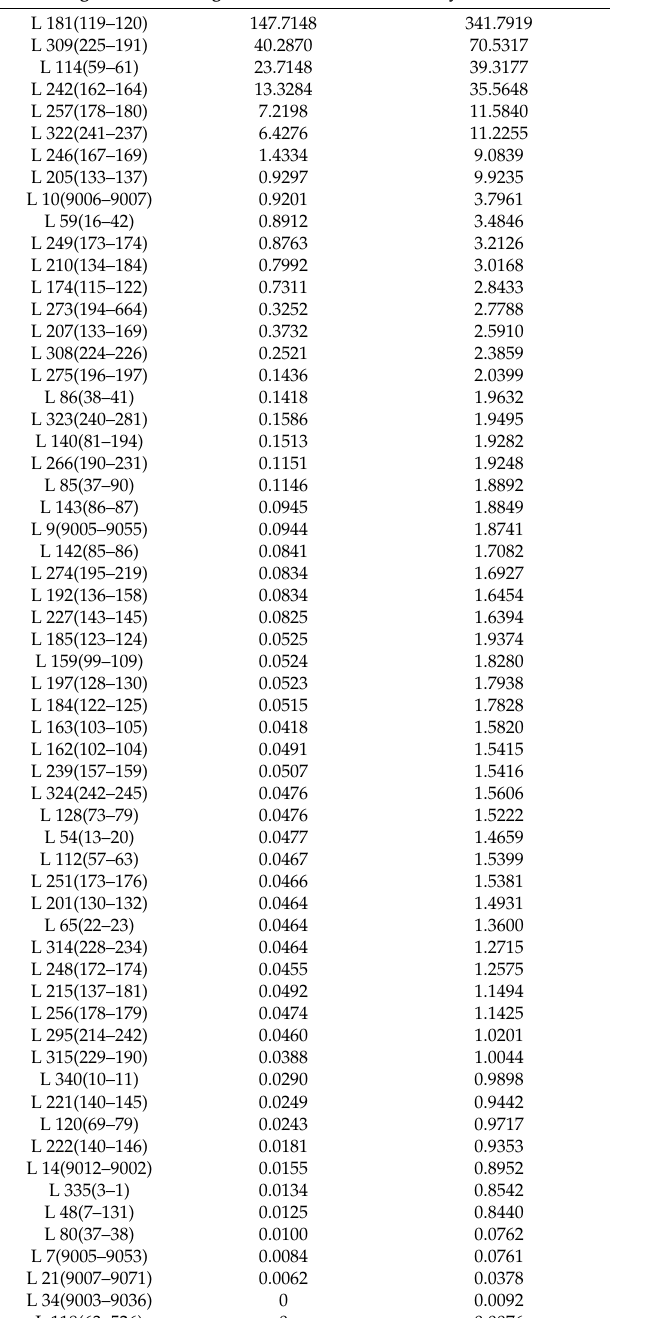
Table 16. Security index results of light and heavy load conditions of the IEEE 300-bus